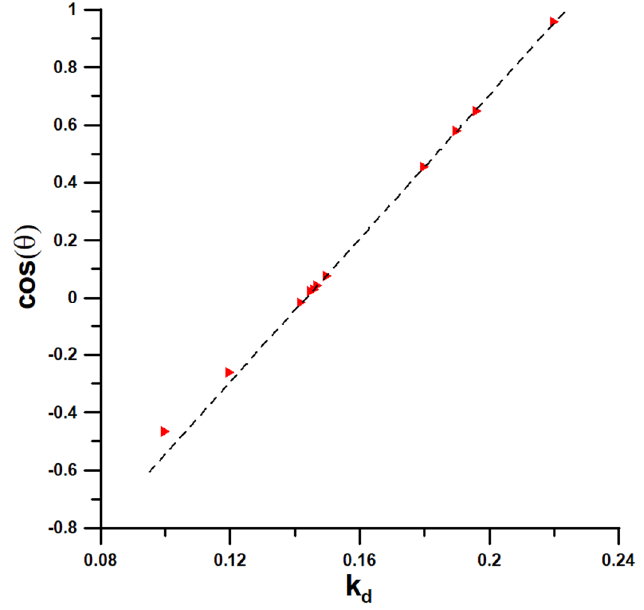
Figure 4. Dependence of the simulated cosine of WCA vs. k d at 298.15 K.